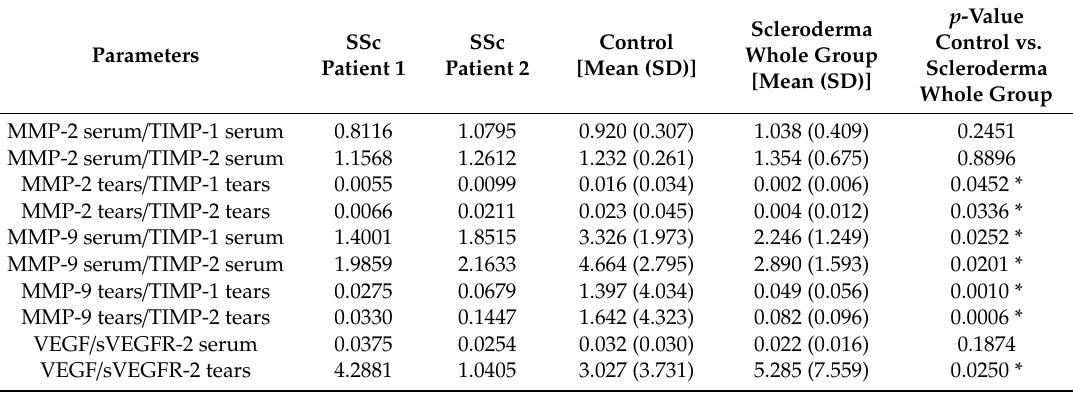
Table 2. Coe ffi cients of laboratory parameters for two patients with ischaemic retinopathy (SSc 1 and 2) and comparison of coe ffi cients between all SSc patients and